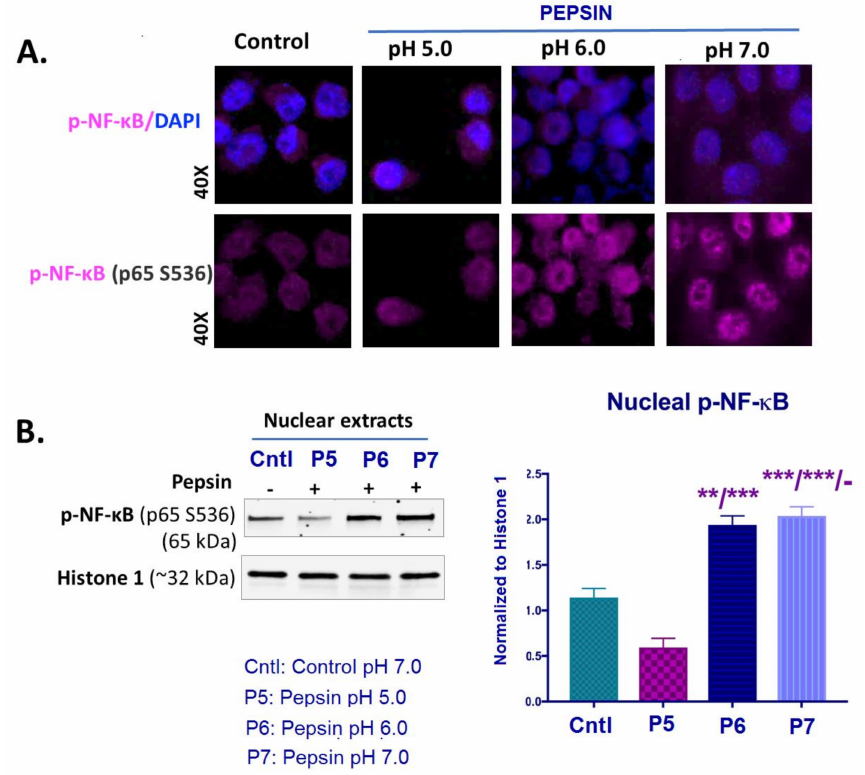
Figure 4. The effect of pepsin on NF- κ B activation in HCs exposed at weakly acidic pH 5.0, slightly acidic pH 6.0 and neutral pH 7.0. ( A ) . Immunofluorescence staining for p-NF- κ B (p65 S536) (purple: p- NF- κ B; blue: DAPI for nuclear DNA staining; scale bar 20 um by Zen imagining software). ( B ). Graph depicts the nuclear protein levels of p-NF- κ B (p65 S536) in pepsin and control-treated HCs, by western blot analysis (Histone 1 was used to normalize nuclear protein extracts). ( t -test; multiple comparisons by Holm-Sidak, ** p < 0.005; *** p < 0.0005; GraphPad Prism 7.0; means ± SD of three independent